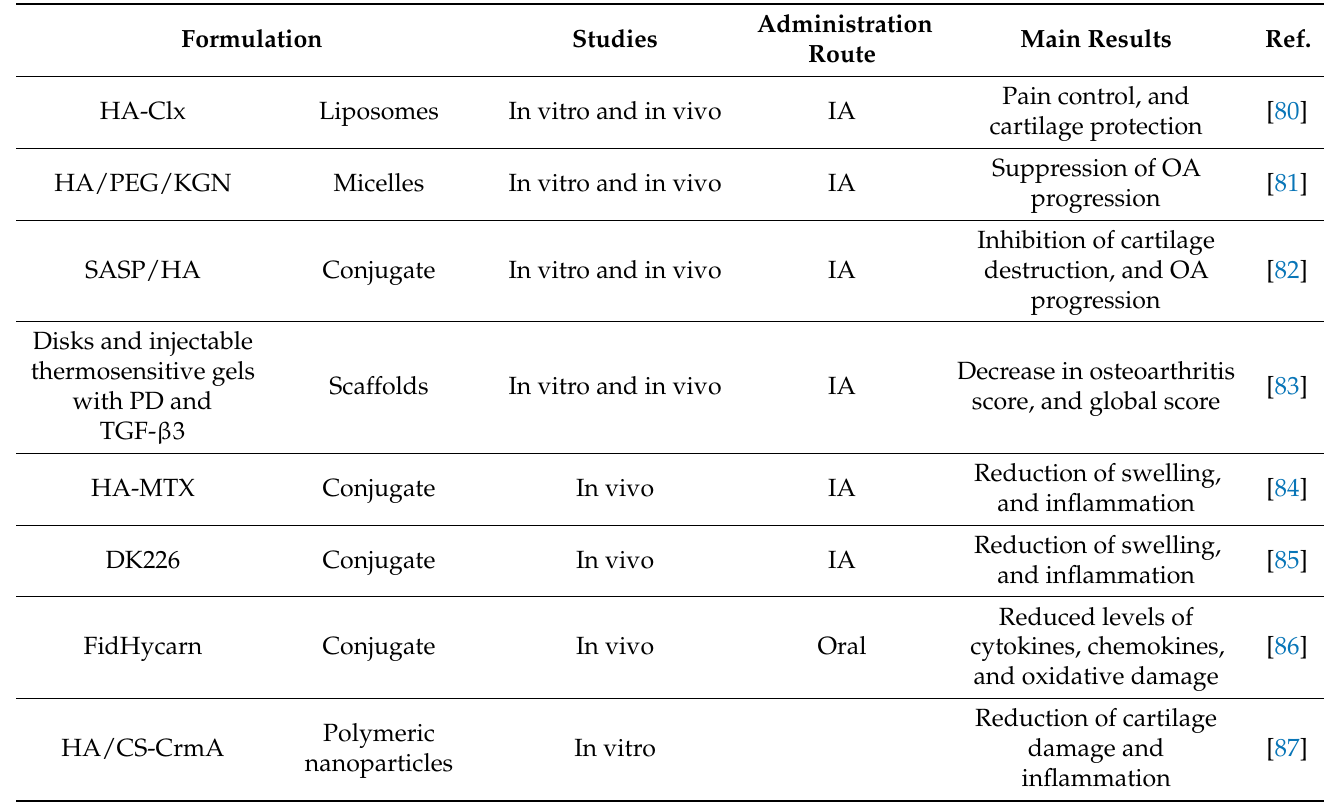
Table 1. Study summaries, with HA, for the treatment of